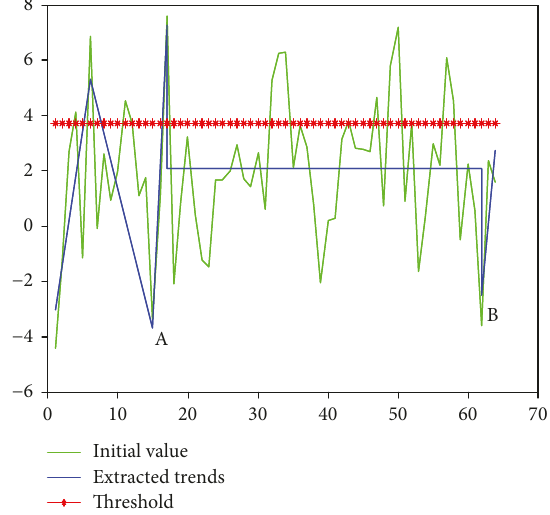
Figure 9: Initial value and extracted trends of T